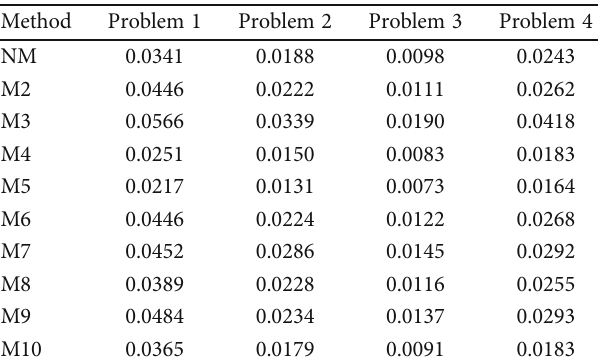
Table 3: Values of CR1 for methods 1-10 to solve all test problems, and n = 500 .